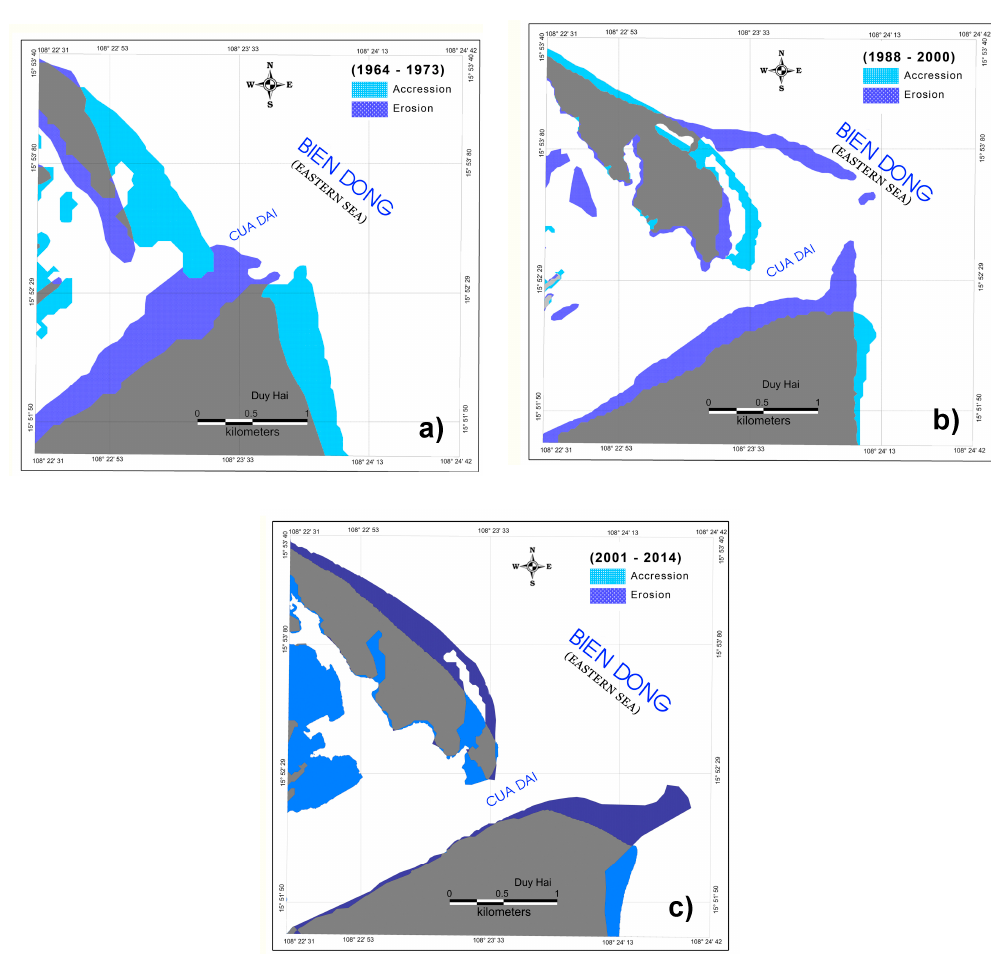
Figure 4 . The post-class change detection during the periods of ( a ) 1964–1973, ( b ) 1988–2000, and ( c ) 2001–2014 in the Cua Dai estuary.